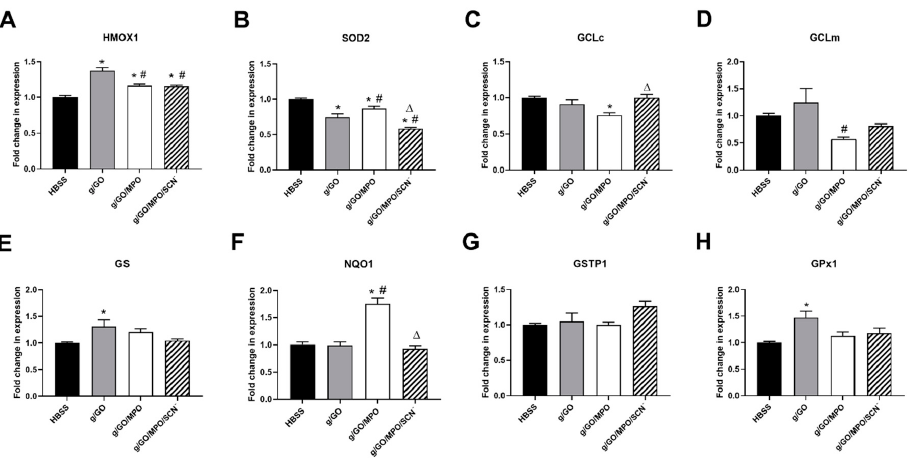
Figure 3. The effect of the GO/MPO enzymatic systems on antioxidant gene expression. J774A.1 cells (5 × 10 5 ) were incubated in HBSS containing glucose (5.6 mM) (black bars), with GO (50 mU mL − 1 , grey bars), GO/MPO (50 nM, white bars), or GO/MPO/SCN - (200 µM, hatched bars) for 1 h at 37 °C before re-incubation in cell media for 24 h. Expression of antioxidant genes, HMOX1 ( A ), SOD2 ( B ), GCLc ( C ), GCLm ( D ), GS ( E ), NQO1 ( F ), GSTP1 ( G ), and GPx1 ( H ) was measured using qPCR. Data